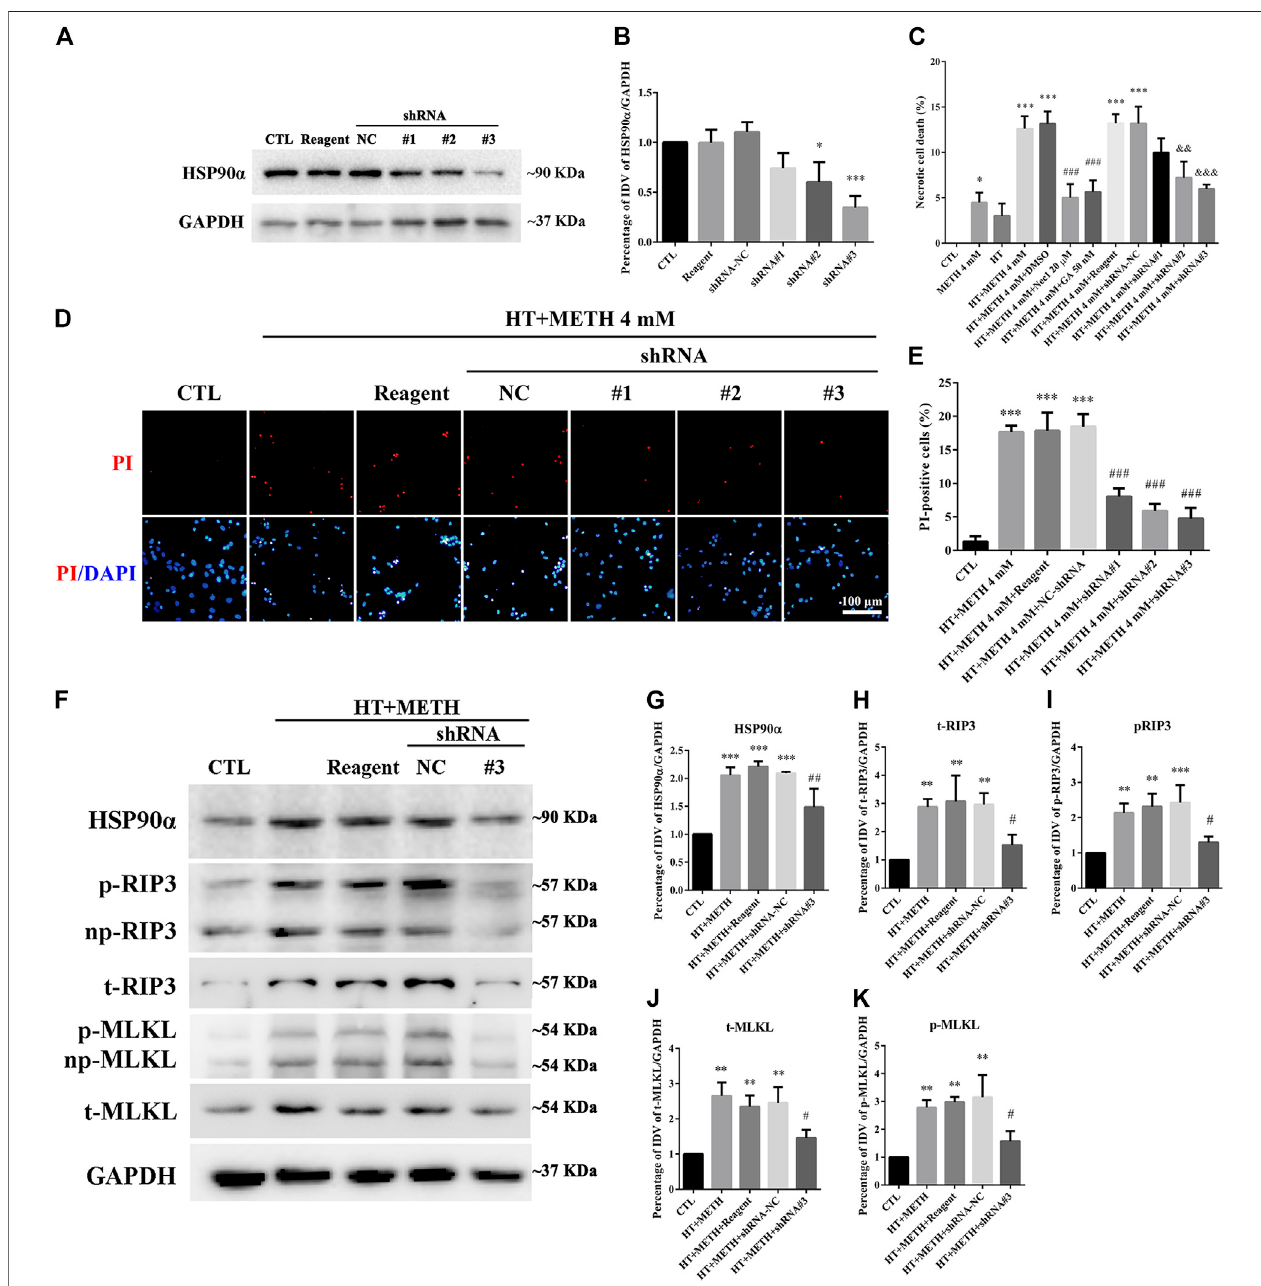
FIGURE 6 | HSP90 α shRNA protected primary striatal neurons from METH/HT-induced necrosis. (A) The protein level of HSP90 α after infection with lentivirus in primaryculturesofstriatalneuronsdetectedbyWB.Reagent,infectionreagentwithoutshRNAgroup;NC,infectionreagentwithnegativecontrolofshRNAgroup;#1-3, infection reagent with the indicated sequence of HSP90 α shRNA group (B) Statistical analysis of HSP90 α WB. Data were analyzed by one-way ANOVA, followed by a Tukeymultiplecomparisonsposttest( n (cid:2) 3).* p < 0.05,*** p < 0.001vs.CTLgroup. (C) ThepercentageofnecroticneurondeathafterMETH/HTtreatmentandpre- treatment with Nec-1, GA, and HSP90 α shRNA was determined with LDH release assays. Data were analyzed by one-way ANOVA, followed by a Tukey multiple comparisons posttest ( n (cid:2) 3). * p < 0.05, *** p < 0.001 vs. CTL group; ### p < 0.001, && p < 0.01, &&& p < 0.001 vs. HT + METH 4 mM group, respectively. (D) PI (red)/ DAPI(blue)doublestainingofstriatalneuronsafterMETH/HTtreatmentandpre-treatmentwith HSP90 α shRNA. Scalebar (cid:2) 50 μ m. (E) StatisticalanalysisofthePI/DAPI double staining of necrotic cells. Data were analyzed by one-way ANOVA, followed by a Tukey multiple comparisons posttest ( n (cid:2) 3). *** p < 0.001 vs. CTL group; ### p < 0.001 vs. HT + METH 4 mM group. ( F) WB of HSP90 α , RIP3, p-RIP3, MLKL, and p-MLKL after METH/HT treatment for 6 h and pre-treatment with HSP90 α shRNA. (G – K) Statistical analysis of WB of HSP90 α , RIP3, p-RIP3, MLKL, and p-MLKL expression. Data were analyzed by one-way ANOVA, followed by a Tukey multiple comparisons posttest ( n (cid:2) 3). ** p < 0.01, *** p < 0.001 vs. CTL group; # p < 0.05, ## p < 0.01 vs. HT + METH 4 mM group.